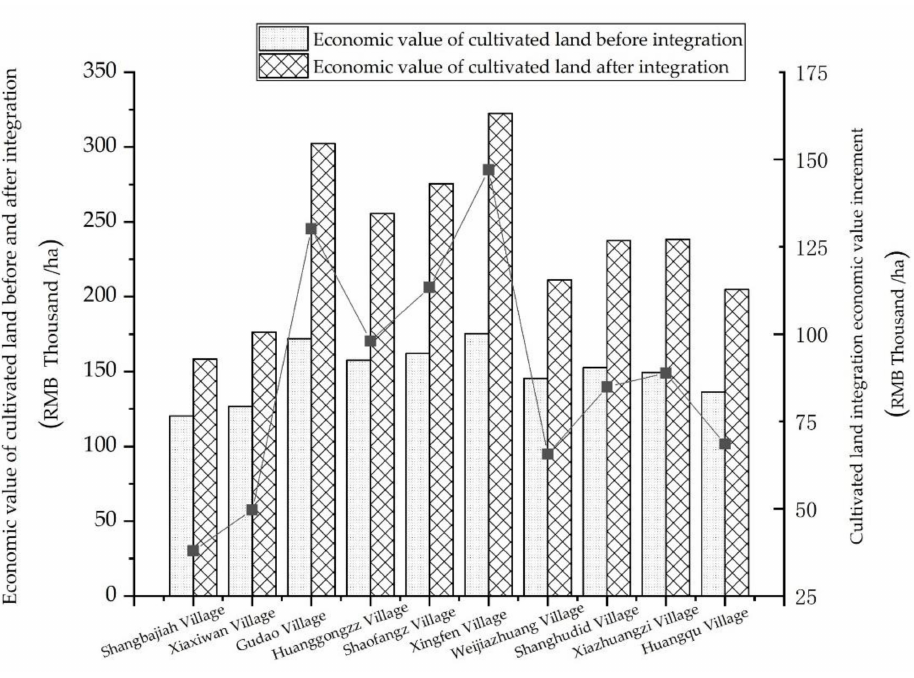
Figure 3. Economic value before and after the integration of cultivated